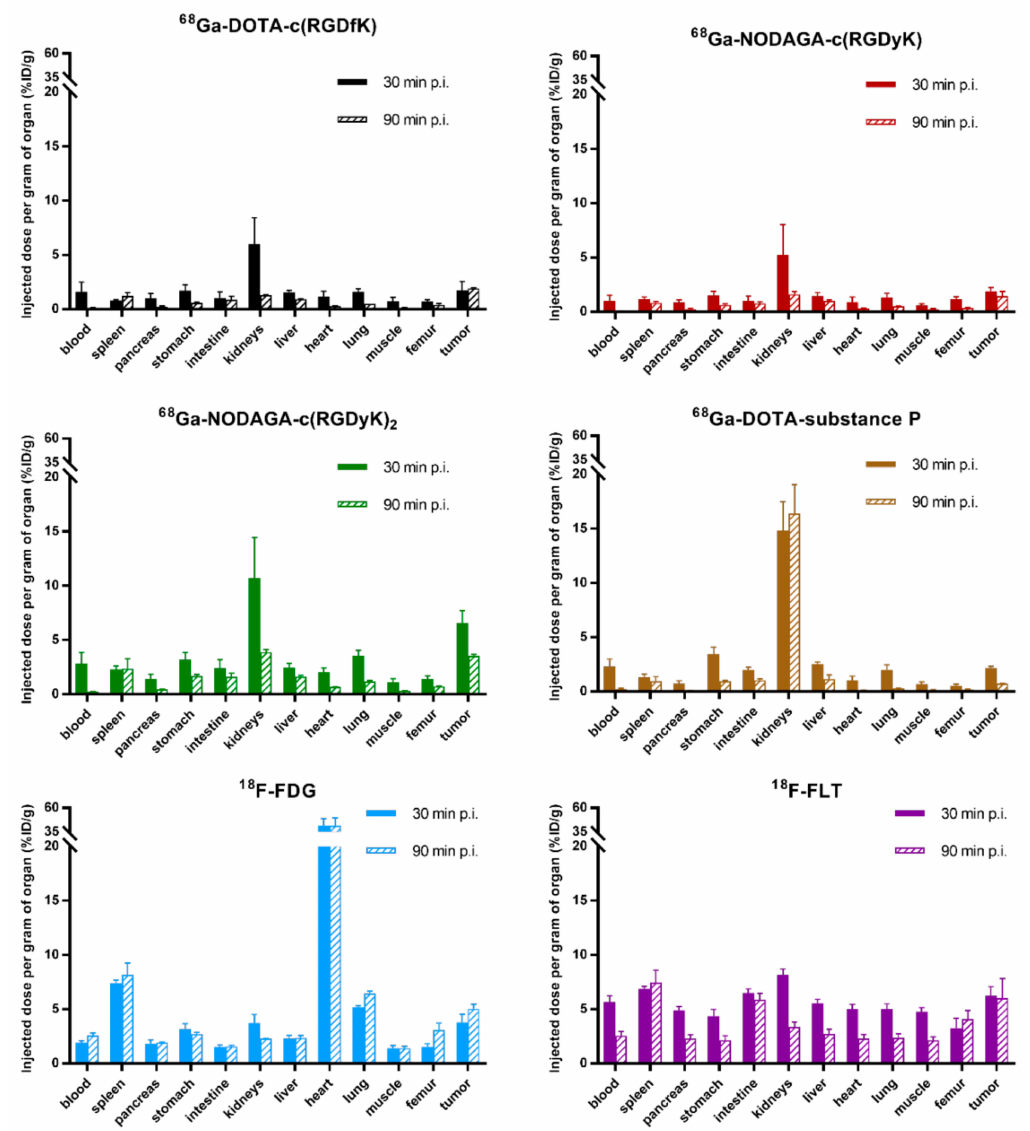
Figure 3. Ex vivo biodistribution of 68 Ga-peptides and 18 F-tracers in U-87 MG tumor SCID mouse 30 and 90 min p.i. The data are presented as the mean of the percentage of injected dose per gram of organ ± standard deviation (n =